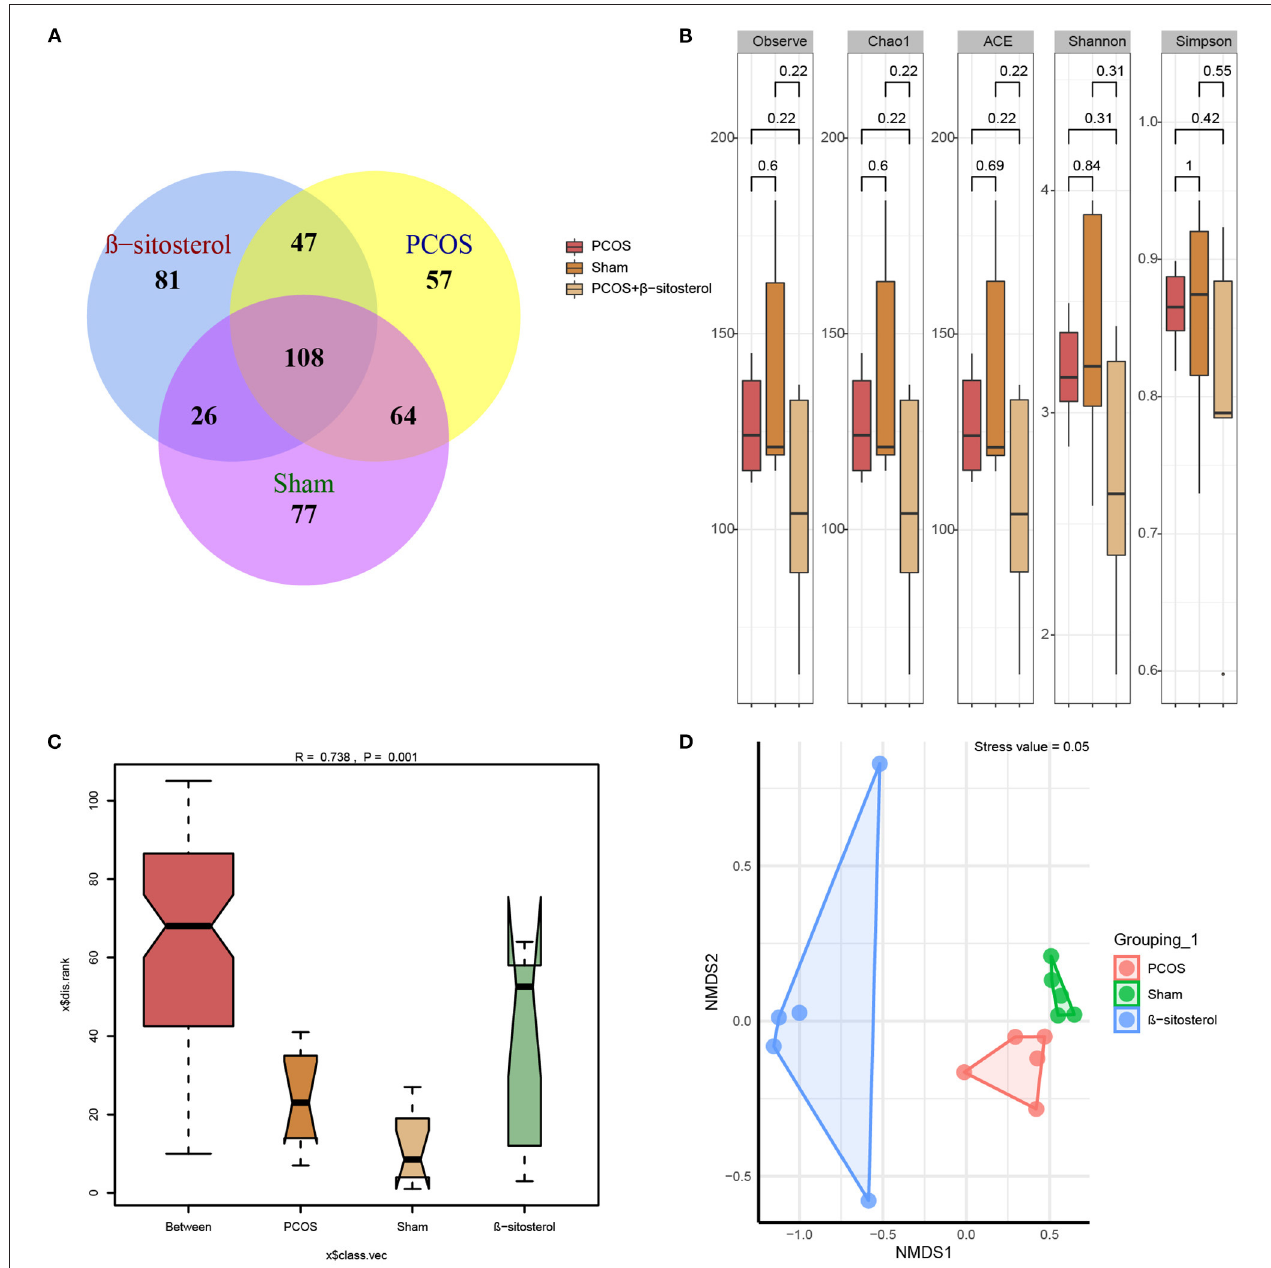
FIGURE 4 | Effects of β -sitosterol on the composition of gut microbiota in PCOS-like mice. (A) Venn diagrams demonstrated the results of operational taxonomic units in groups. (B) Changes in Observe, Chao1, ACE, Shannon, and Simpon indices. (C) Analysis of similarities showed differences in groups. (D) Nonmetric multidimensional scaling analysis showed differences in groups. PCOS, polycystic ovary syndrome; FSH, follicle-stimulating hormone; P, progesterone; LH, luteinizing hormone; T, testosterone.